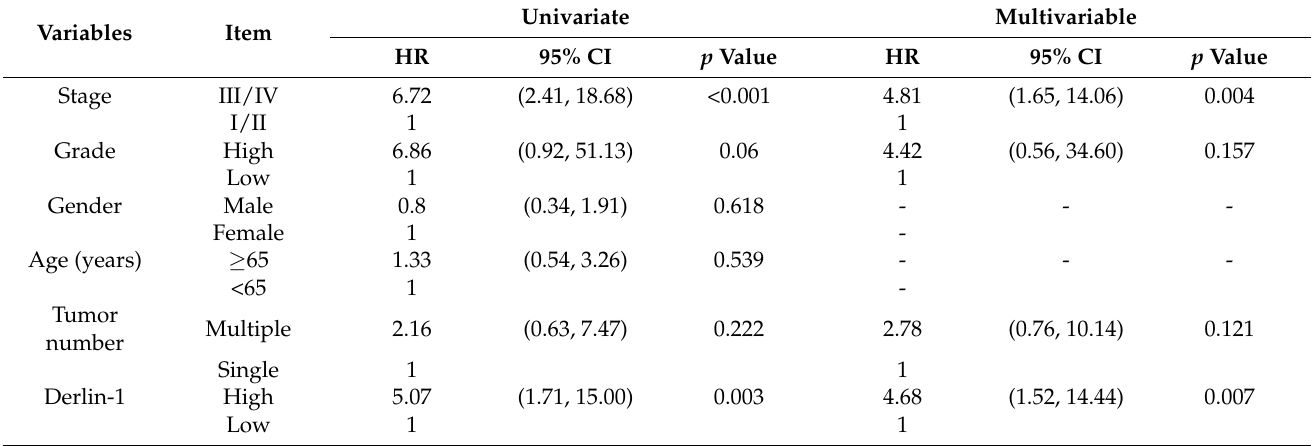
Table 3. Analysis of progression-free survival for UTUC.